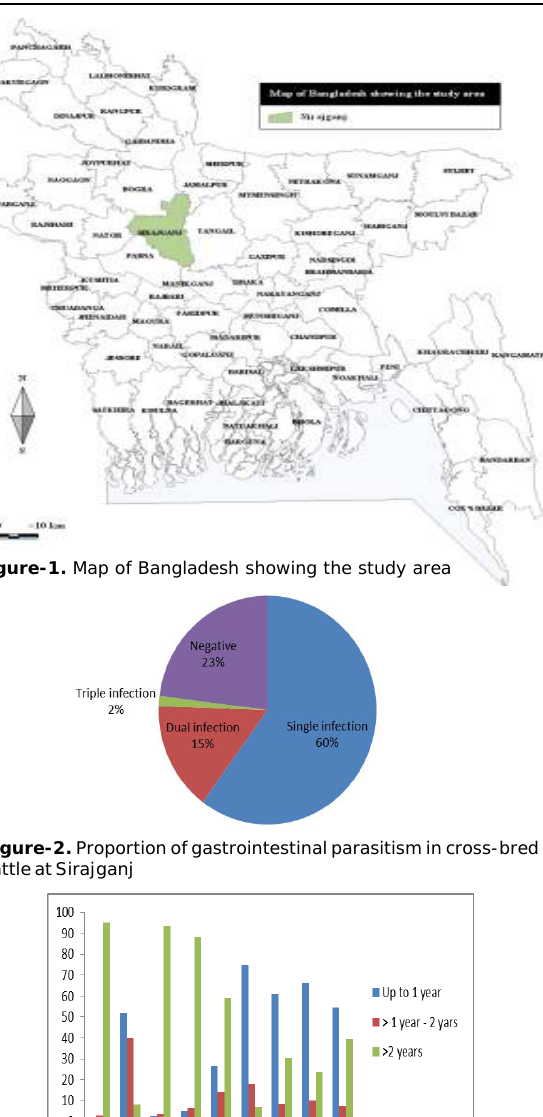
Figure-3. Age related proportion of gastrointestinal parasitism in cross-bred cattle at Sirajganj